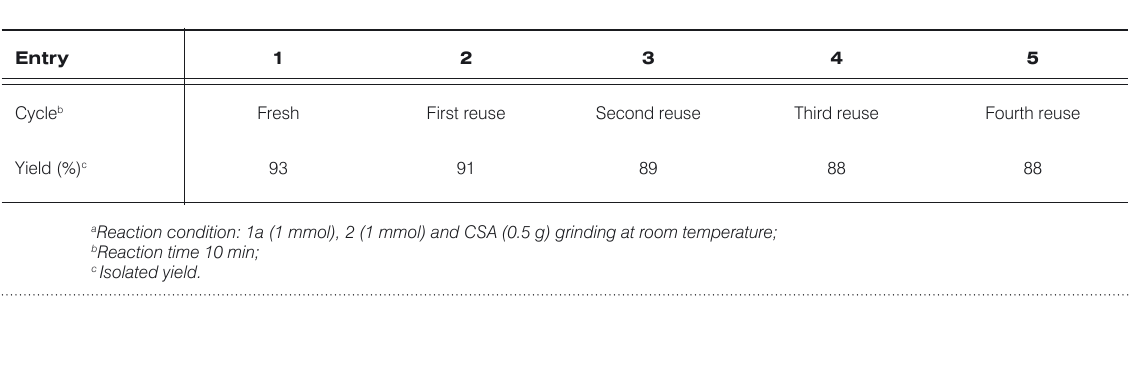
Table 4. Recycling of CSA for the synthesis of 2,2-dimethyl-5-[(4-oxo-4H-chromen-3-yl)methylene]-1,3-dioxane-4,6-dione a [Table 2, entry